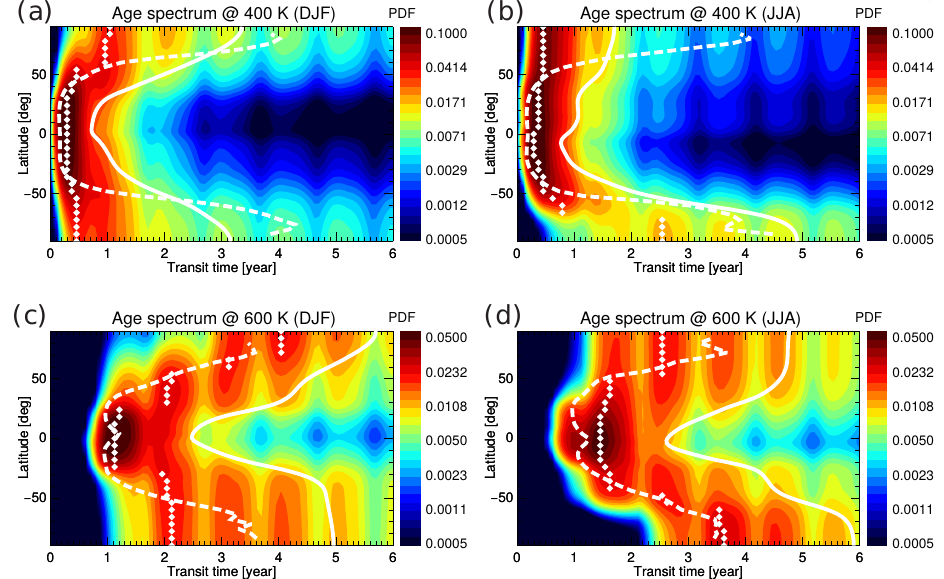
Figure 9. Age spectra at 400K for (a) December–February and (b) June–August. (c) and (d) show the same but at 600K. White lines show mean age (solid) and the residual circulation transit time (dashed). White diamonds show modal